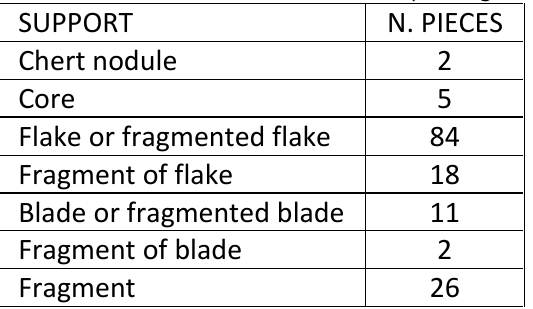
Table 2. Chert materials distribution depending on the support.